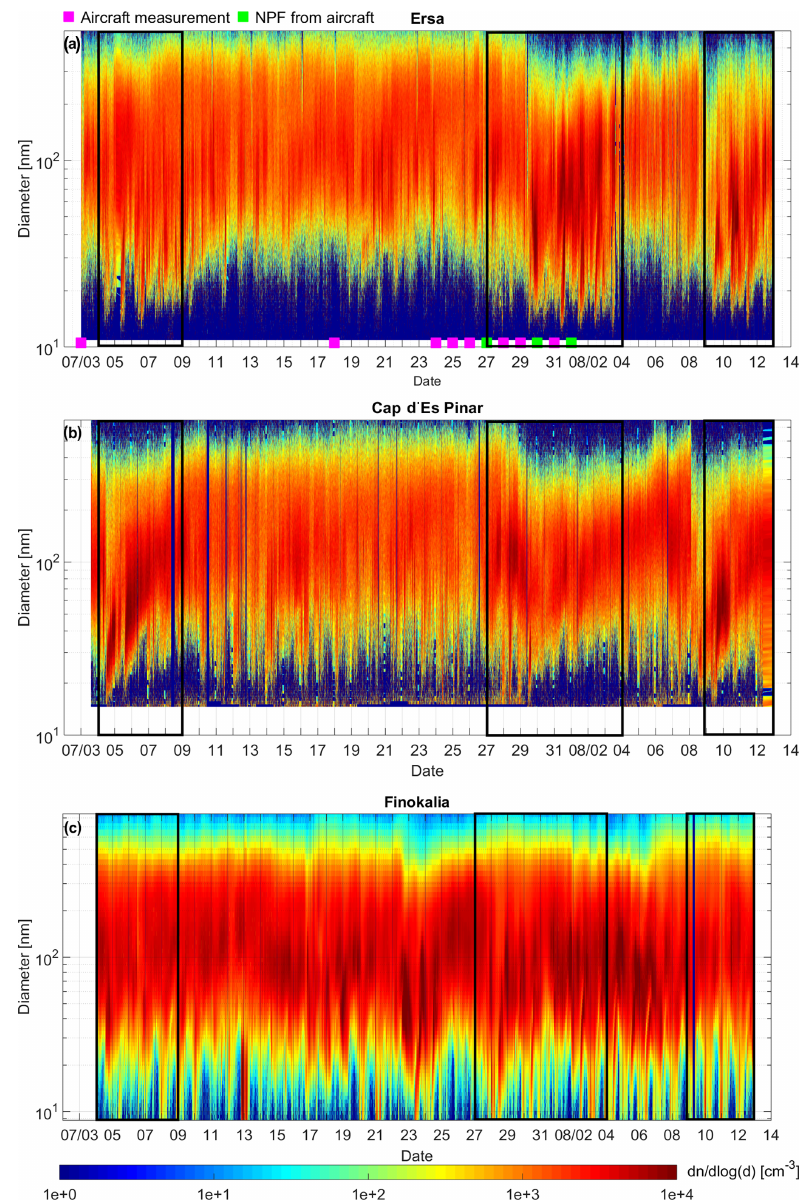
Figure 7. SMPS particle number size distribution in (a) Ersa, (b) Cap d’Es Pinar and (c) Finokalia during the SOP. The three NPF episodes observed at large scale are highlighted on the spectra in the black boxes. The days of occurrence of the ATR-42 flights are also shown, together with the detection of NPF from these airborne measurements. Same color scale applies to (a–c)